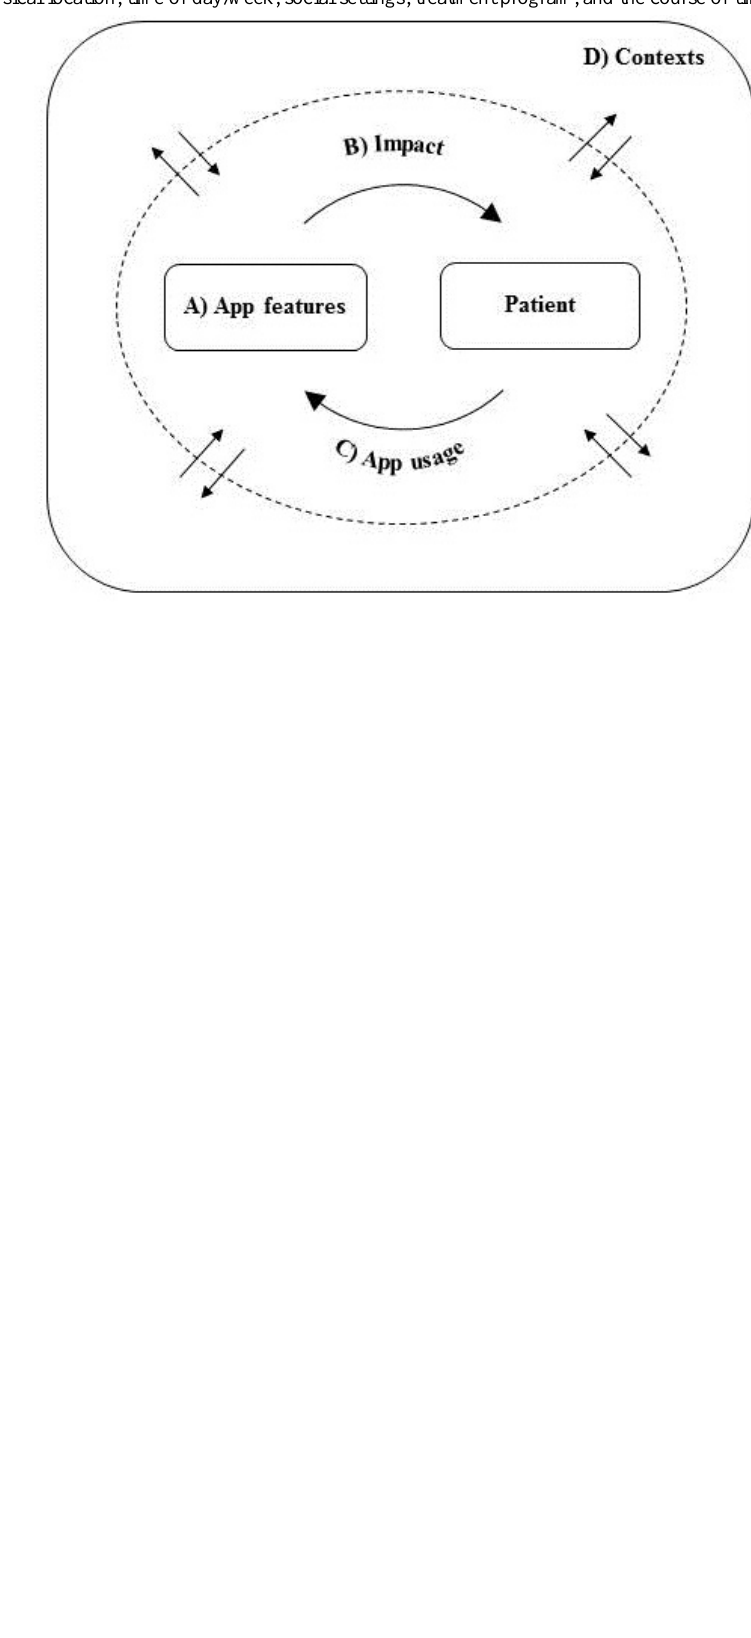
Figure 3. Illustration of results. The figure depicts the patient-app interaction, ie. the interaction between A) the Recovery Record features, B) the impact of these on patients, and C) patients' specific app usage. This patient-app interaction (dotted circle) affected and was affected by D) patients' contexts (outer box), ie. physical location, time of day/week, social settings, treatment program, and the course of